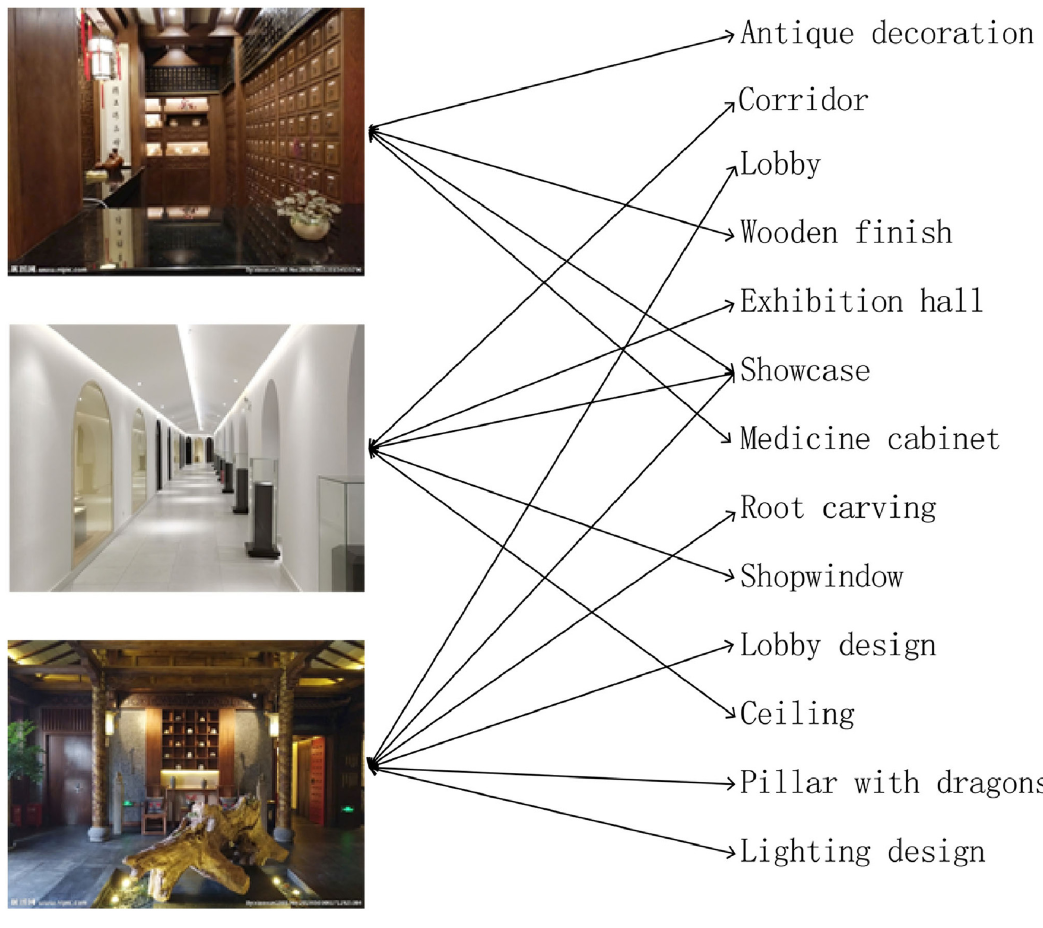
Fig 1. Example of picture-tag